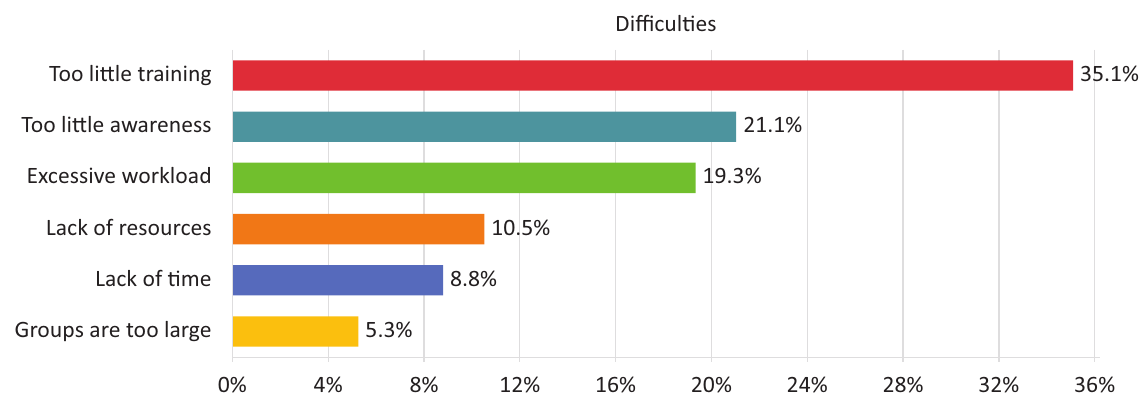
Figure 1. Main difficulties identified by the interviewed faculty members regarding the attention to